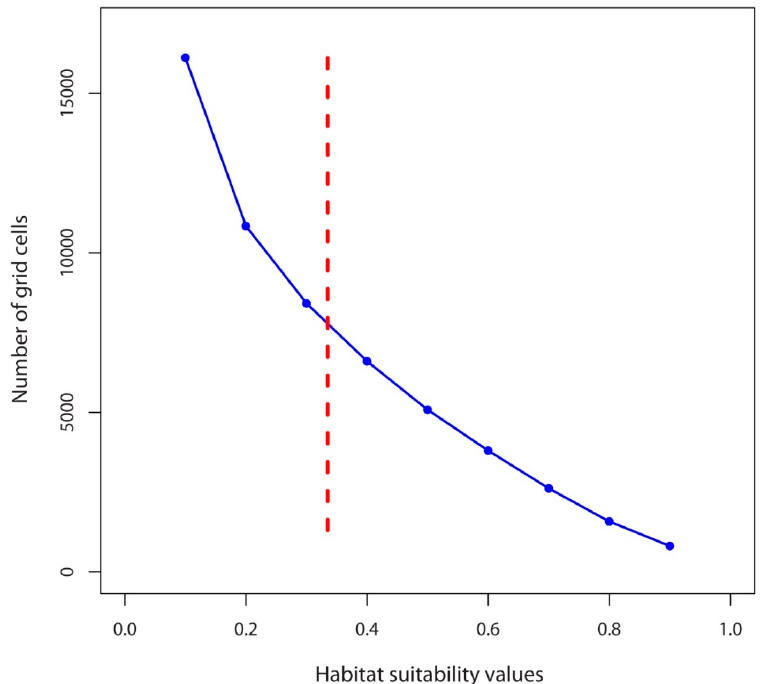
Figure 7. The current number of grid cells in Nepal with particular habitat suitability values. The dashed vertical red line is the lowest presence threshold (LPT = 0.335).